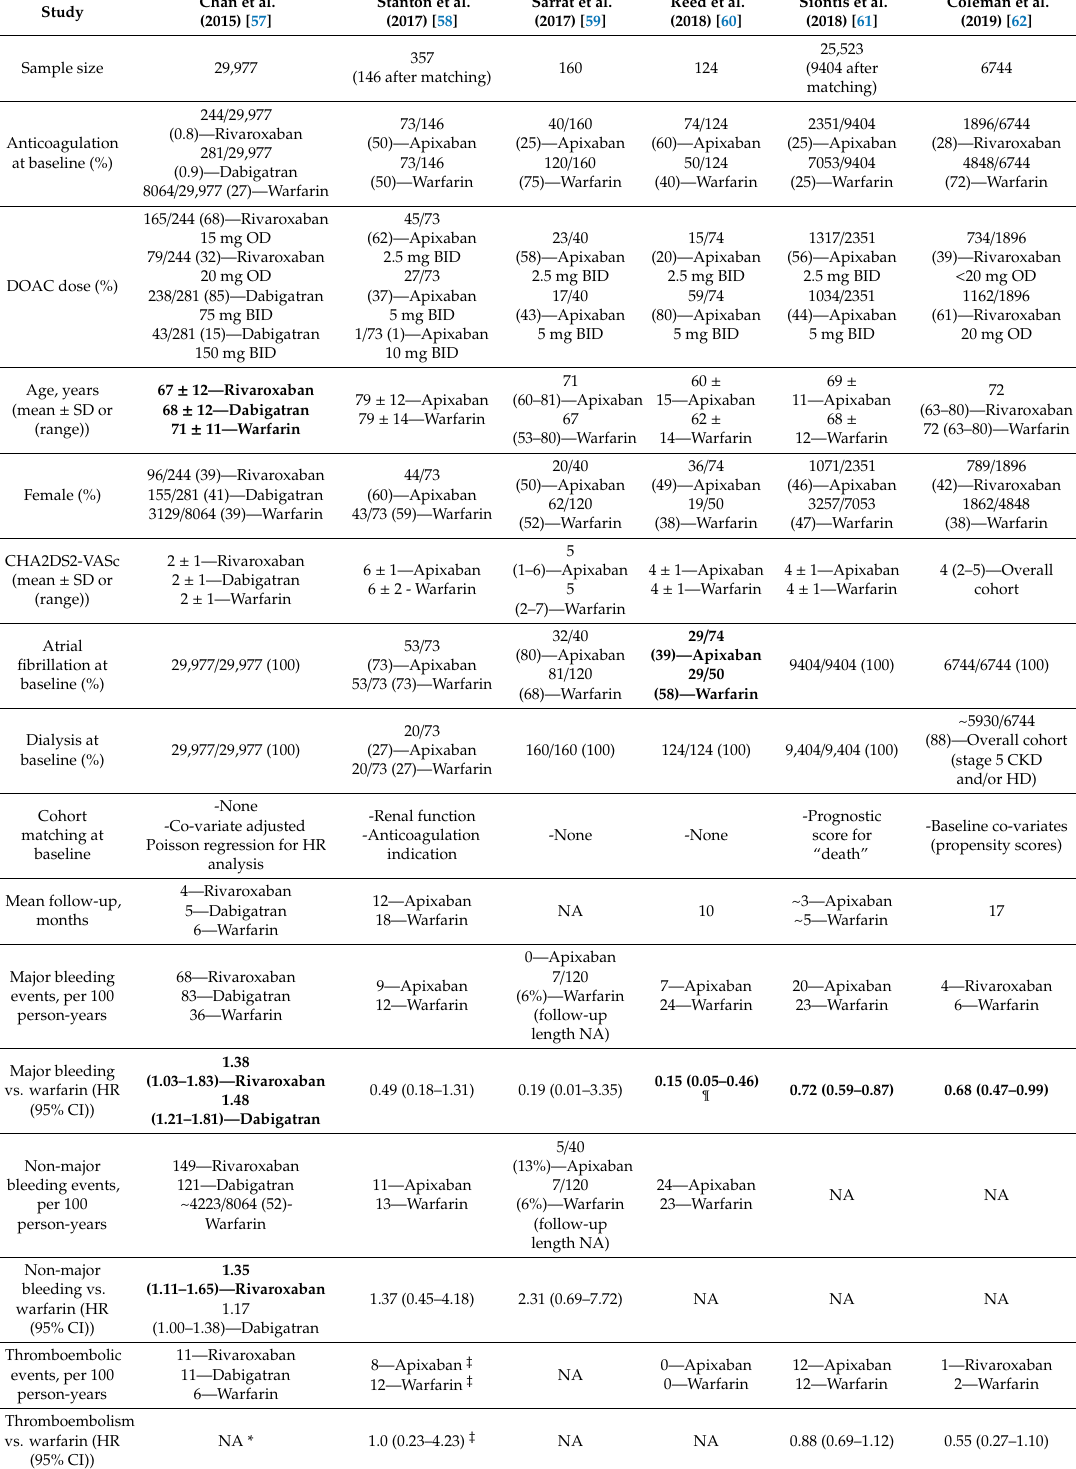
Table 1. Summary of retrospective studies comparing the e ffi cacy and safety of direct oral anticoagulants versus warfarin in end-stage renal disease patients with atrial